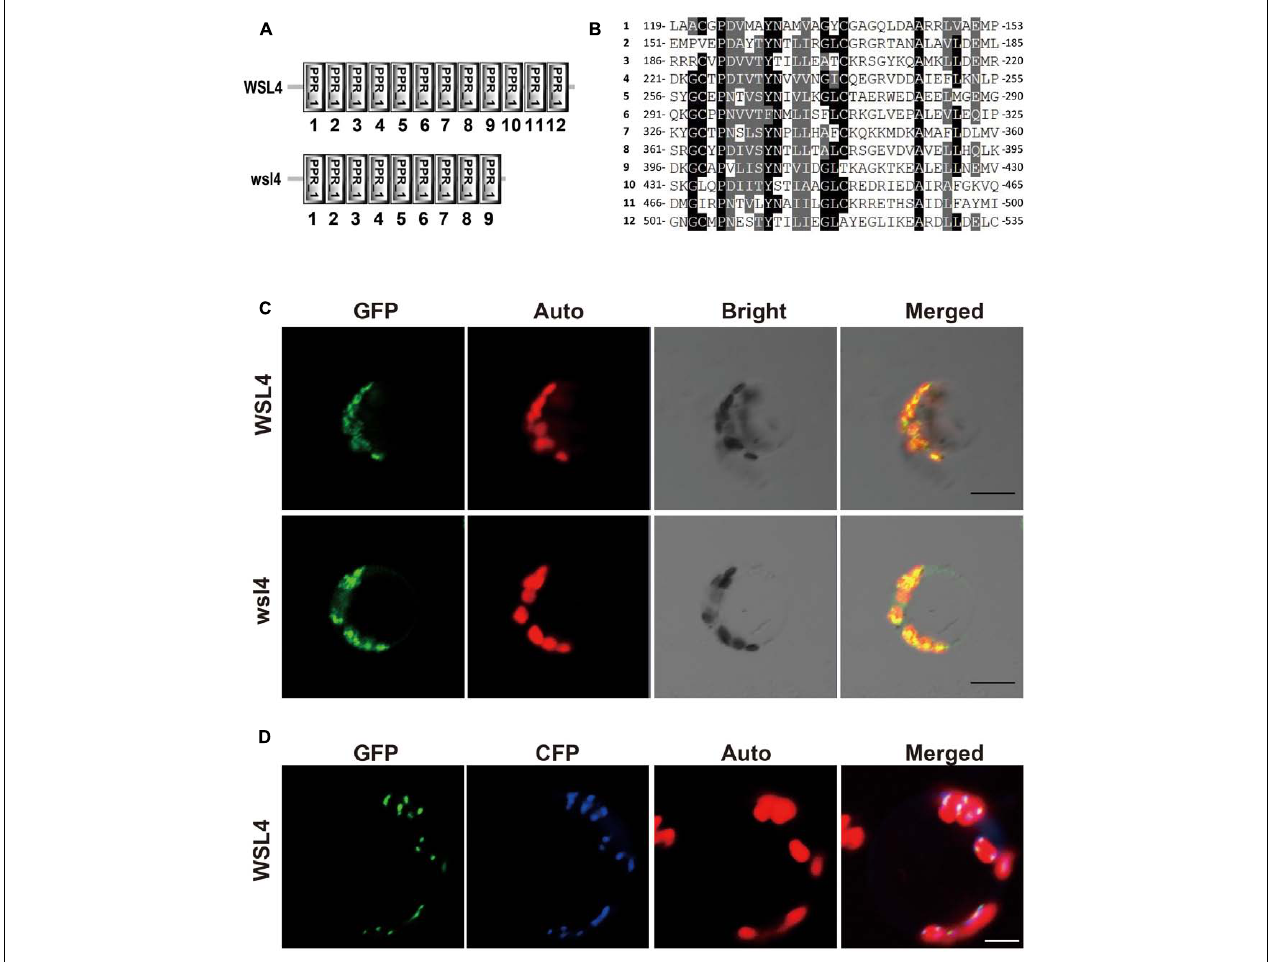
FIGURE 4 | Sequence analysis and subcellular localization of the WSL4 protein. (A) WSL4 protein has 12 PPR motifs, whereas the wsl4 mutant protein contains only 9. (B) The 12 PPR motifs of WSL4. (C) Transient expression of WSL4–GFP and wsl4–GFP fusion proteins in rice protoplasts. (D) Colocalization of WSL4